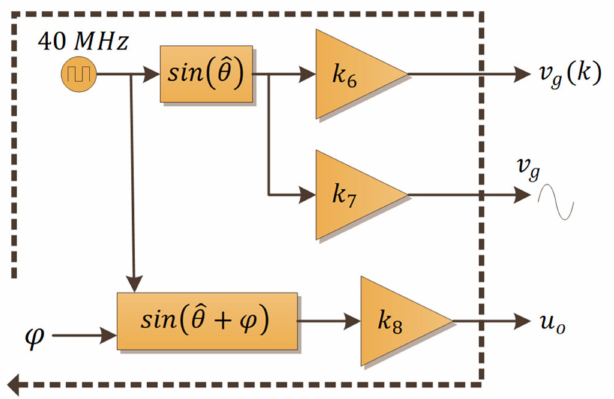
Figure 13. Embedded system to emulate v g and u